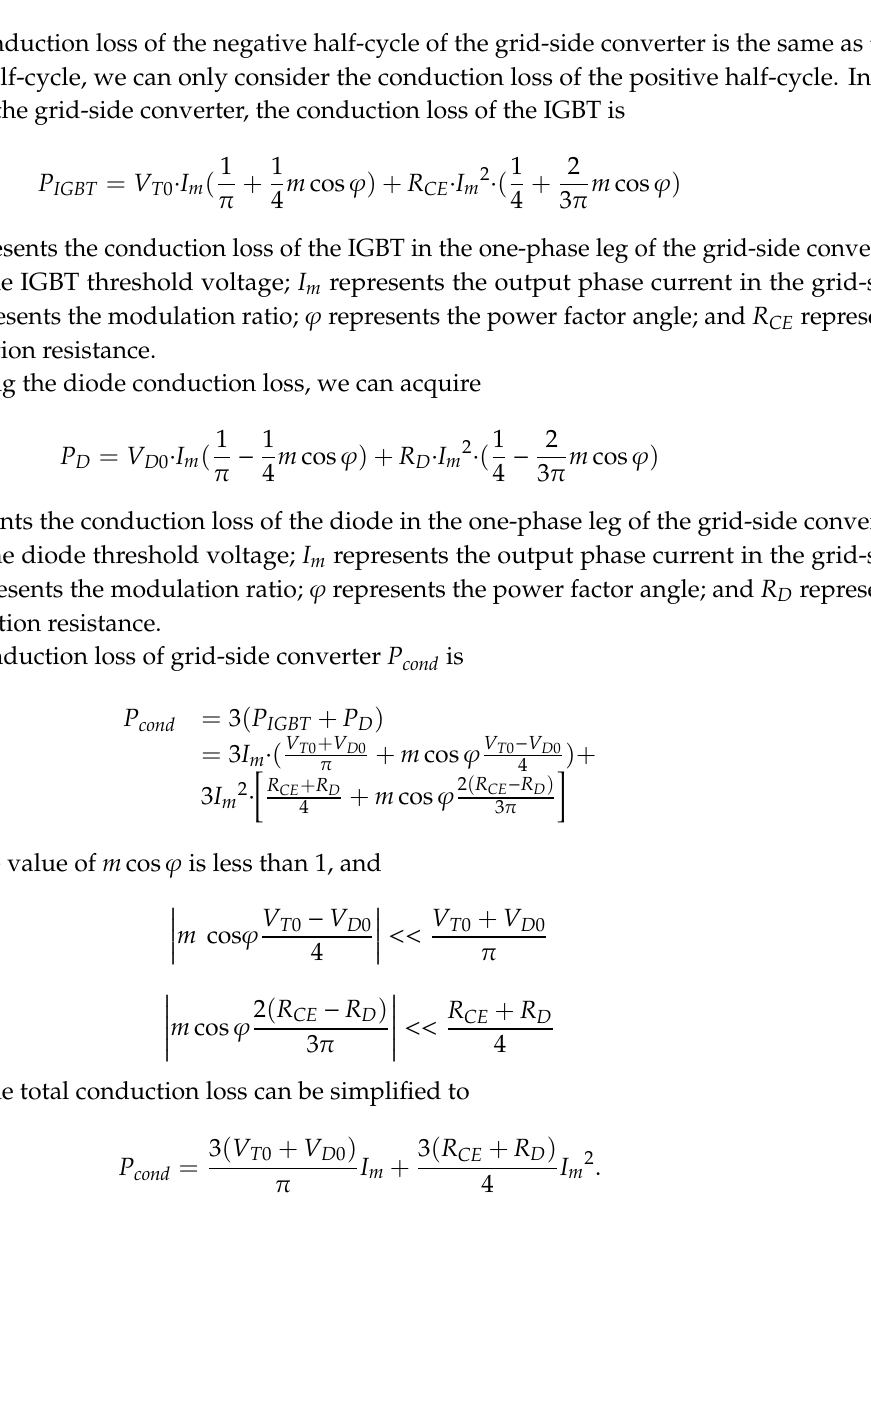
Figure 3. Structure of the flywheel energy storage unit (FESU).